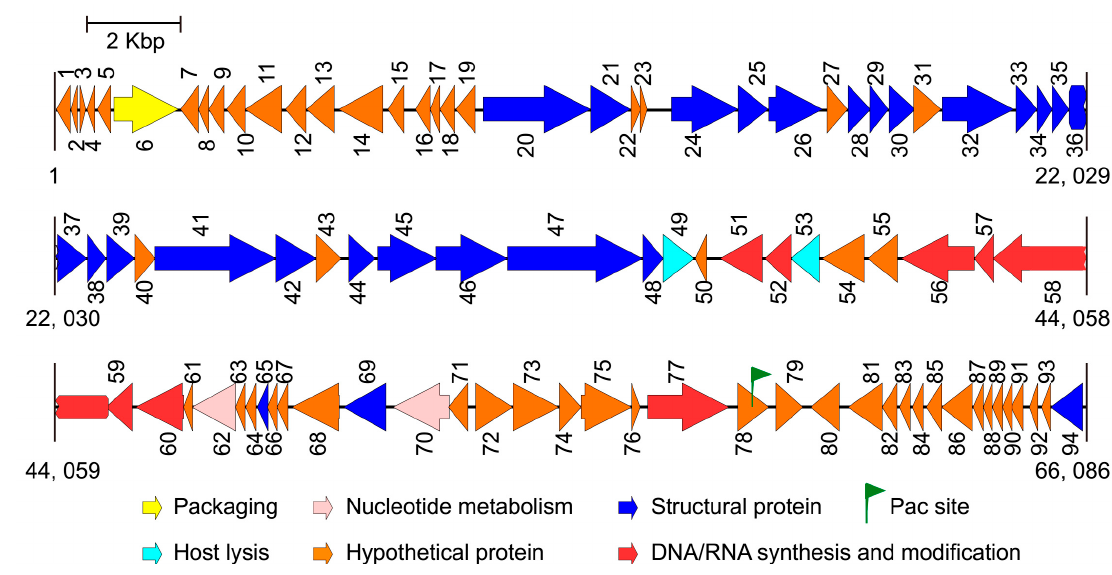
Figure 2. Genome map of phage vB_PaeM_SCUT-S1. The arrows indicate the predicted open reading frames, and the different colors indicate the diverse functions of the coded proteins.